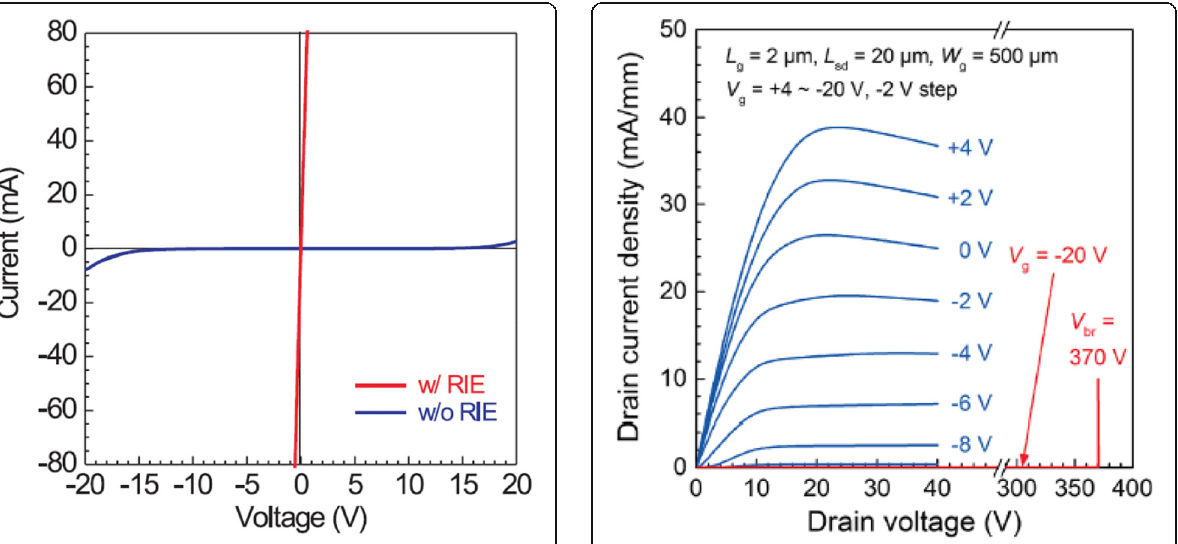
Fig. 3 (Color online) I – V curves measured between two contacts (as-deposited Ti/Au) fabricated with and without RIE treatment on n-Ga 2 O 3 substrates. Reproduced from Ref. [1]